Question: In a single sentence, describe what this figure presents.
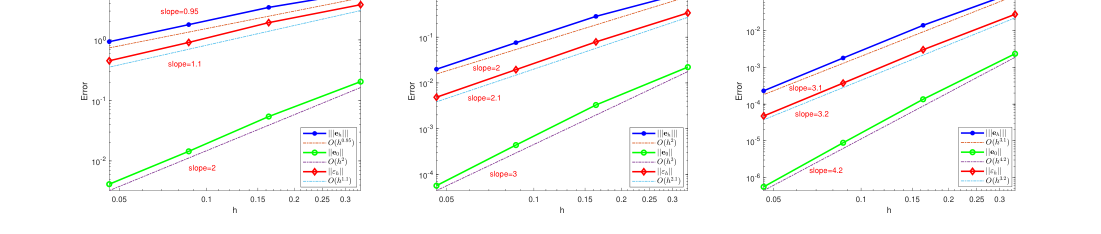
Answer: The numerical results for Example 7.2 on curved triangular meshes with k = 1 (left), 2 (middle), 3 (right).